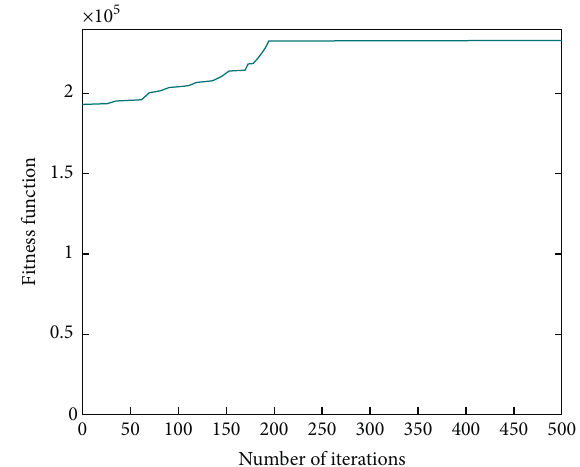
Figure 6: Individual optimal fitness